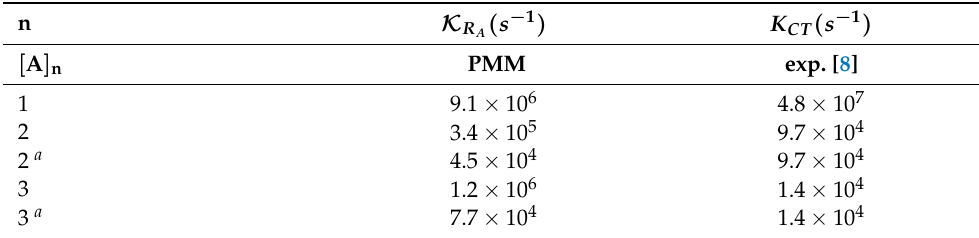
Table 4. Comparison between the calculated kinetic constant K R (obtained removing from the mean A transition energy the solvent contribution) and the experimentally measured rate constant K CT for the intrastrand charge transfer of the G . + – [ A ] n –G 3 sequence containing substrates. When not specified 2 the data refer to fully removed solvent contribution.